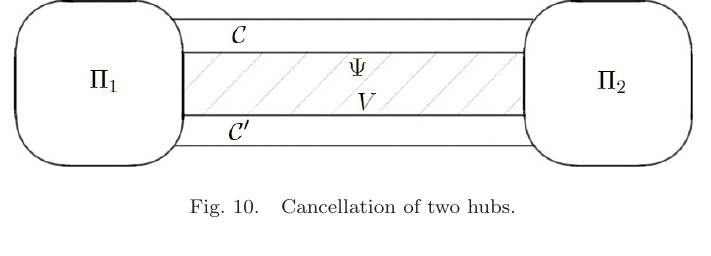
Fig. 10. Cancellation of two